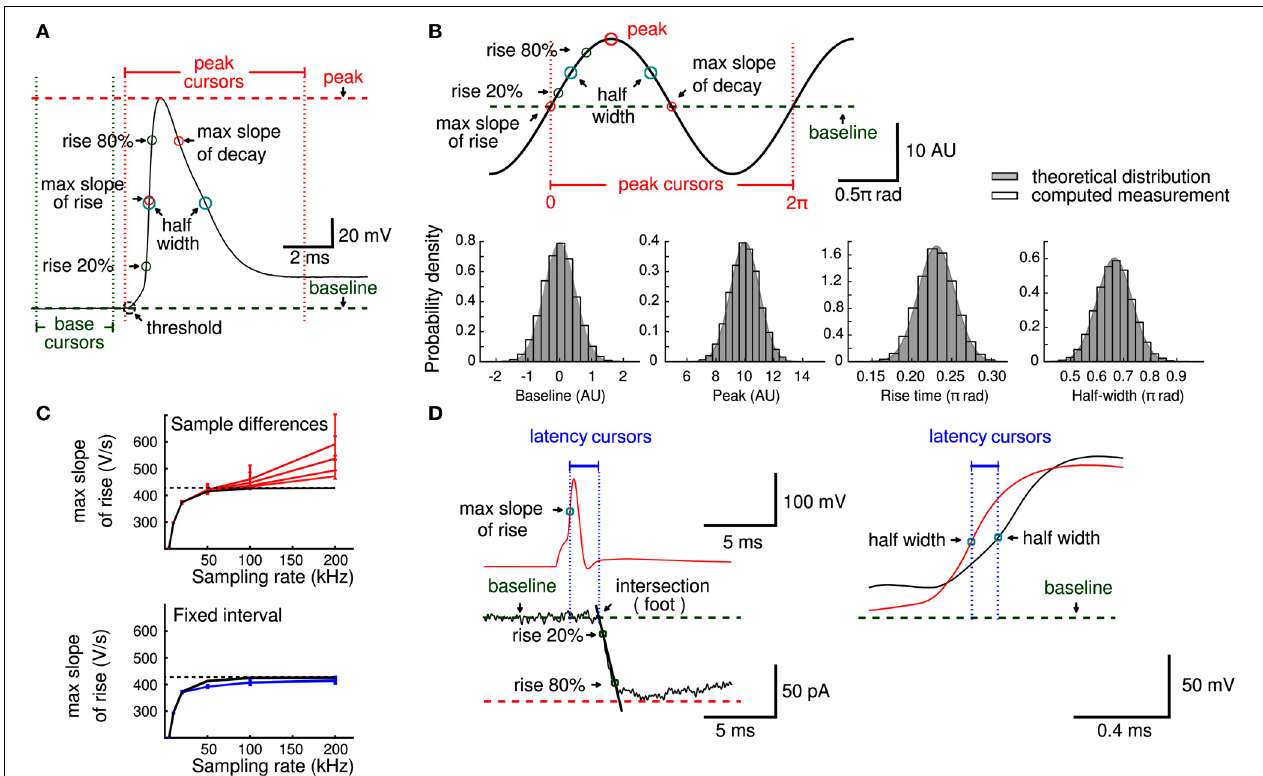
FIGURE 3 | Principal measurements. (A) An action potential showing baseline(green)andpeak(red)cursorsthatdelimittheprincipalmeasurements obtained in layer II of the analysis workflow. (B) An example of a trace used to provide analytical solutions to validate principal measurements (peak 10 arbitrary units, rise time 0.23 π rad, half duration 0.66 π rad, max slope 1 and max decay − 1). Histograms of baseline, peak, rise time and half duration measurements (open bars) show estimated measurements together with the theoretical distribution used to generate the analytical values (gray). (C) The error to estimate the maximal slope depends on sampling rate and measurement noise. The black line is the expected maximal slope when